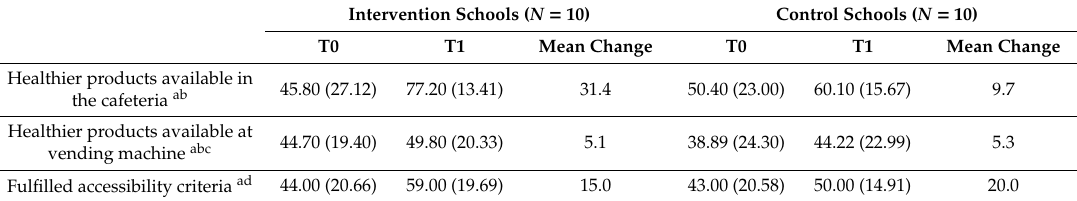
Table 2. Subscores of a healthier canteen pre- and post-intervention, stratified by intervention and control schools.